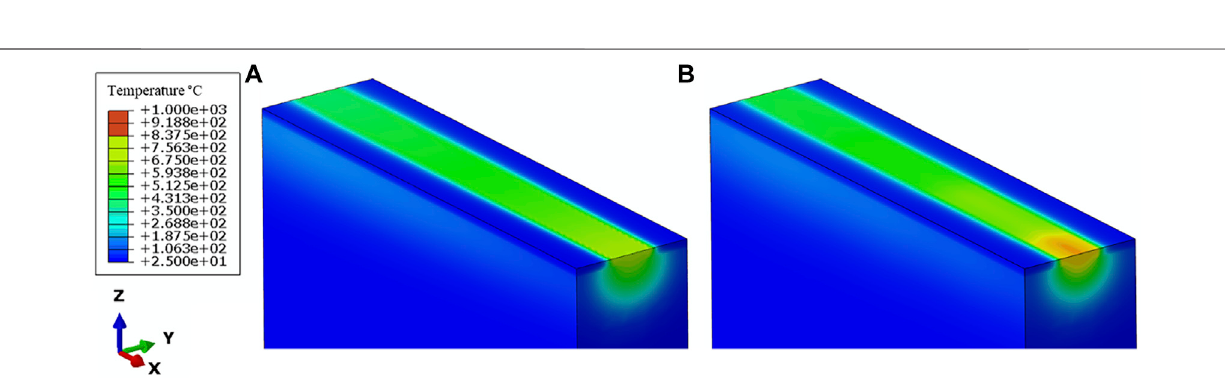
Frontiers in Materials |